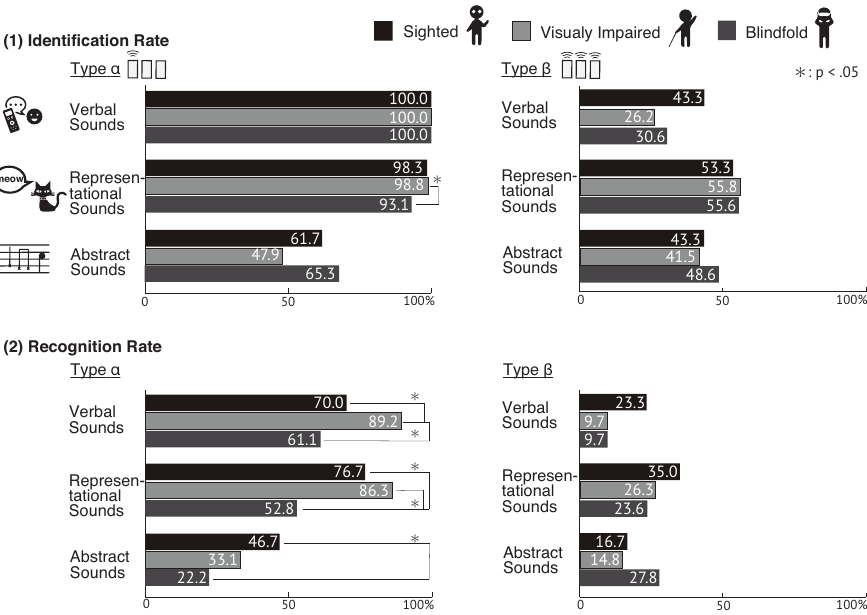
Figure 7. Differences in performance by degree of visual